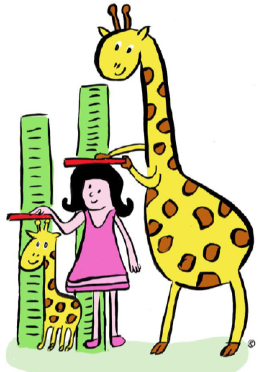
Figure A2. An example of a picture used in the picture selection task.